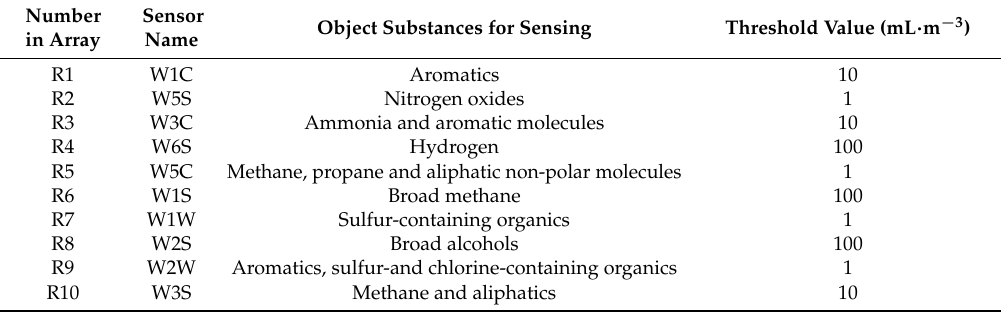
Table 2. Sensor name and performance of electronic nose